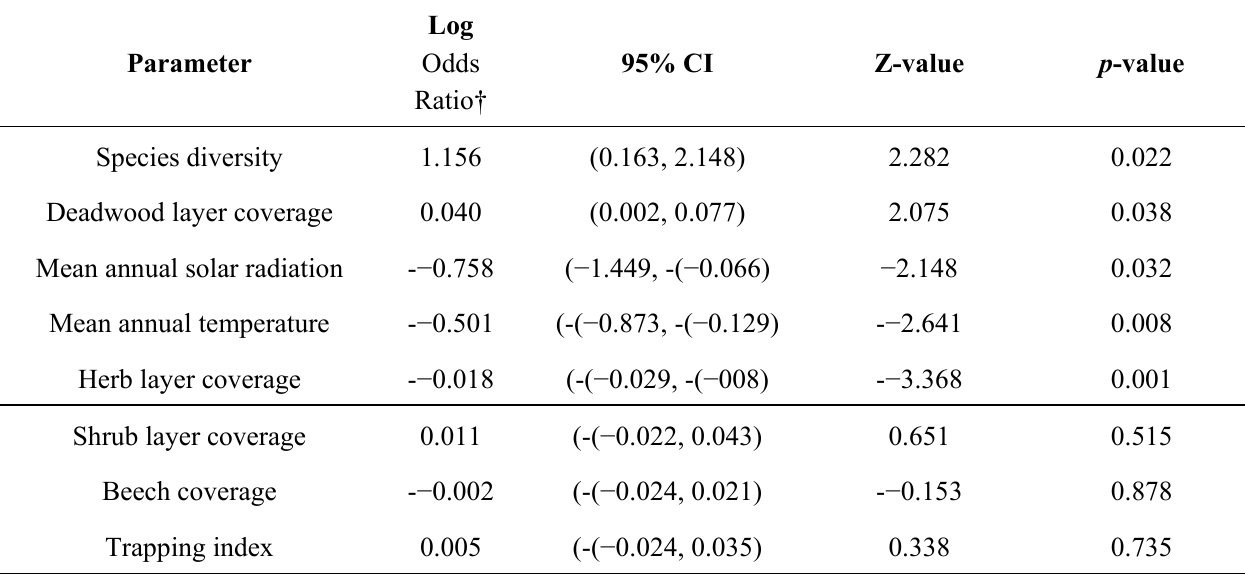
Table 3. Results of a GLMEM with a binomial distribution based on data from 23 sampling plots over three consecutive years (2008–2010). Abbreviation: CI: confidence